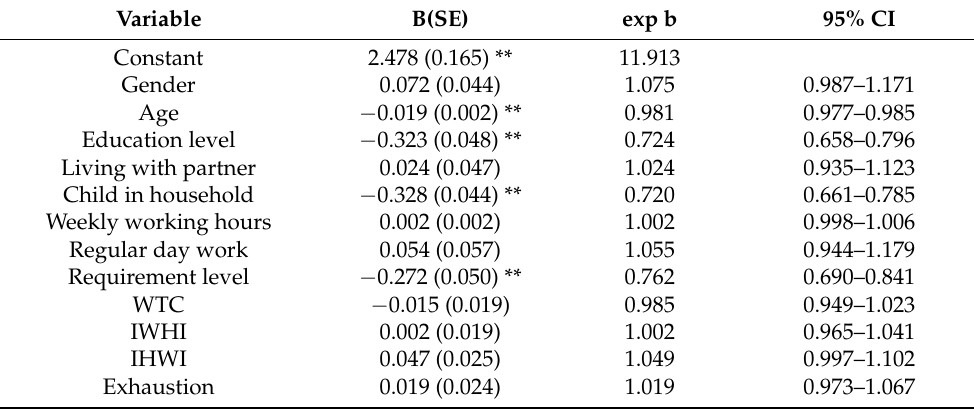
Table A2. Results from multiple logistic regression analysis with study variables and control variables (both at T1) on dropout (stayer = 0, leaver = 1; n = 17,256). R 2 = 0.020 (Cox & Snell), 0.032 (Nagelkerke). Model χ 2 (12) = 346.730 **.